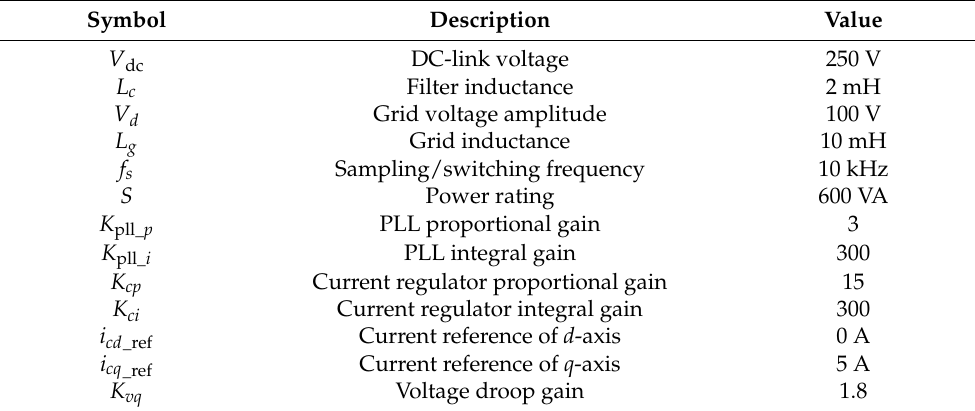
Figure 7. Pole-zero map of G icq _cl_dr ( s ).